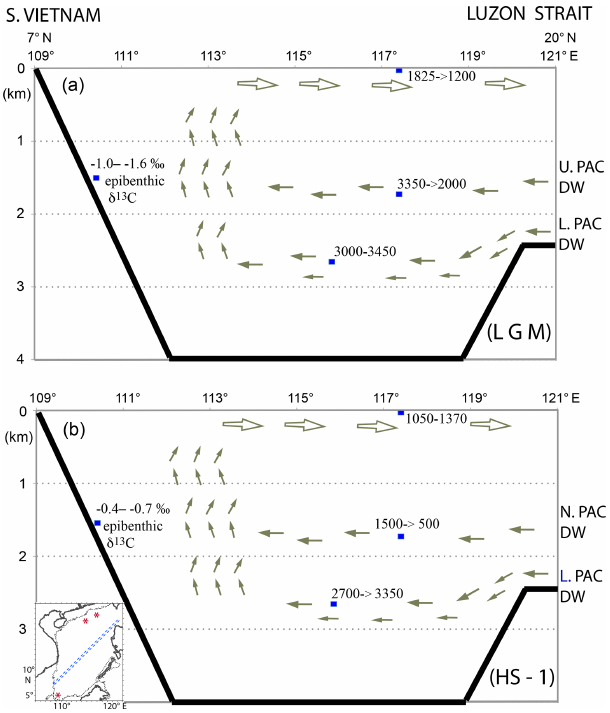
Figure 9. SW–NE transect of 14 C reservoir age and changes in ven- tilation age across sites GIK17940 and SO50-37 in the South China Sea during the late LGM ( 14 C Plateaus 5 and 4; a ) and HS-1 (b) . In- sert map shows the location of the transect and core locations. Core locations are given in Fig. 7. An extreme epibenthic δ 13 C minimum in the far southwest (Core GIK17964; Wang et al., 1999) reflects an LGM incursion of lower and upper Pacific Deep Waters (L. PAC DW and U. PAC DW) with extremely high 14 C ventilation age and DIC enrichment in contrast to a low ventilation age of North Pacific Deep Water (N. PAC DW). Arrows show the direction of potential deep and intermediate water